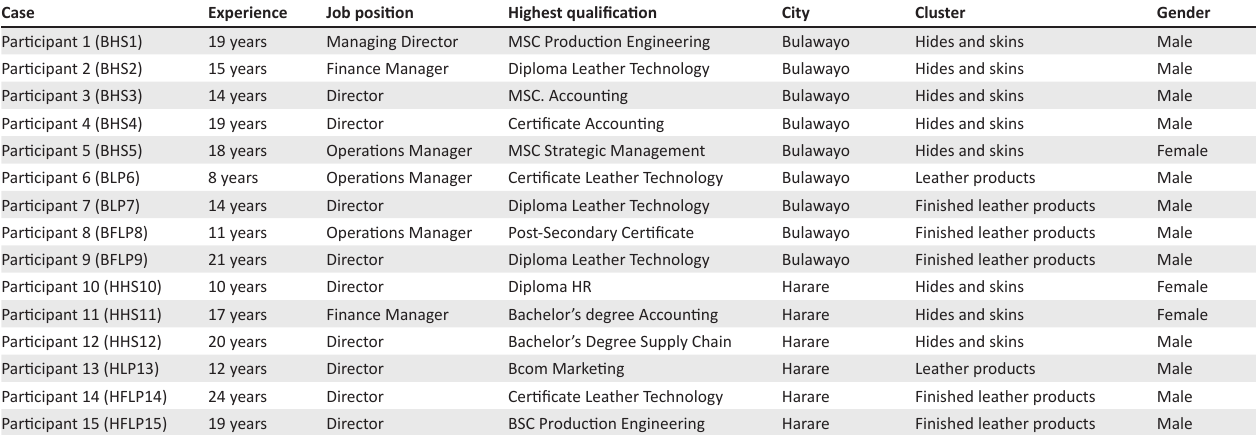
TABLE 2: Demographic profiles of interviewees.